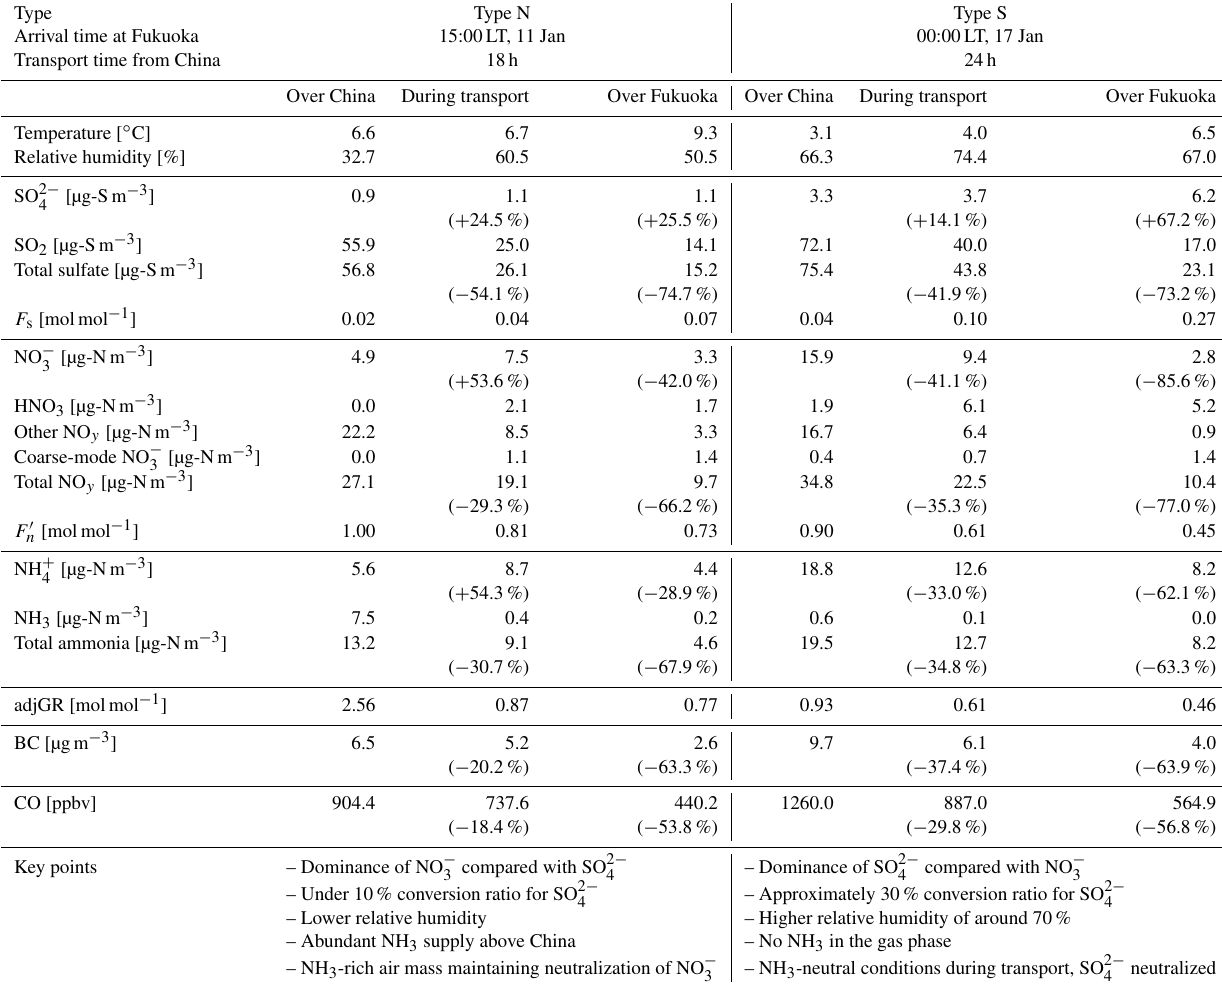
Table 2. Summary of the path analysis for types N and S.